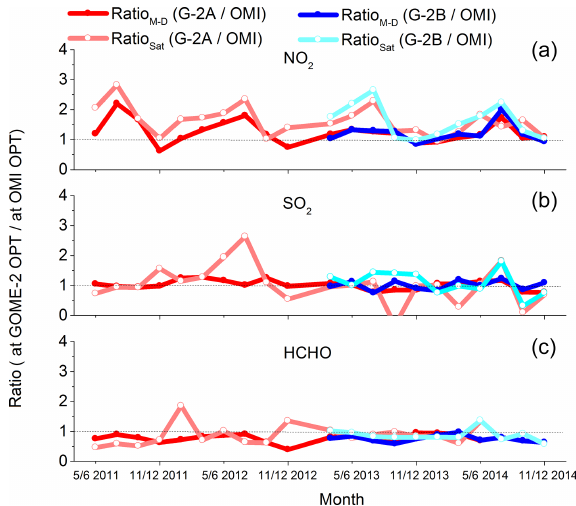
Figure 13. Ratios between the bi-monthly mean tropospheric VCDs from GOME-2A/B and OMI (Ratio Sat ) , as well as the ratios be- tween the corresponding MAX-DOAS observations (Ratio M − D ) for NO 2 (a) , SO 2 (b) and HCHO (c) , respectively. The light red (dark red) and light blue (dark blue) curves are corresponding to GOME-2A and GOME-2B results (coincident MAX-DOAS results with GOME-2A and GOME-2B), respectively. Note that for SO 2 the OMI and GOME-2A data from BIRA are used for the ratio cal- culations. The mean ratios for the shown data sets are presented in Table